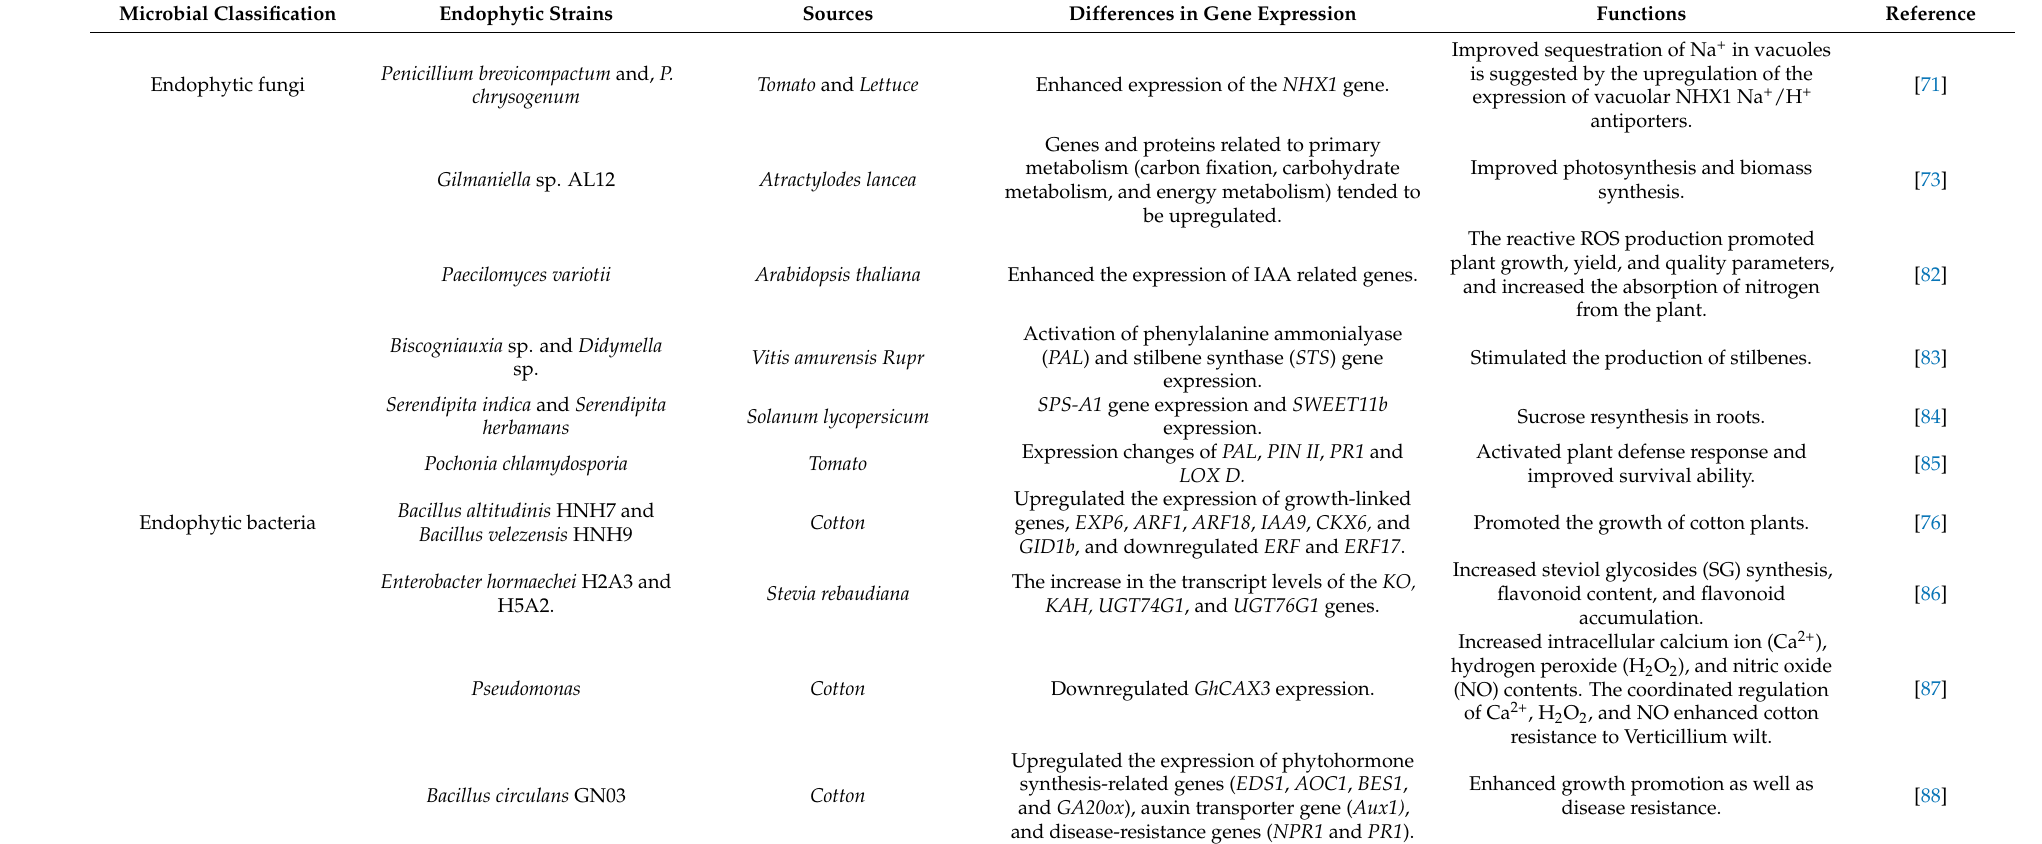
Table 2. Endophytes affect the expression of plant-related